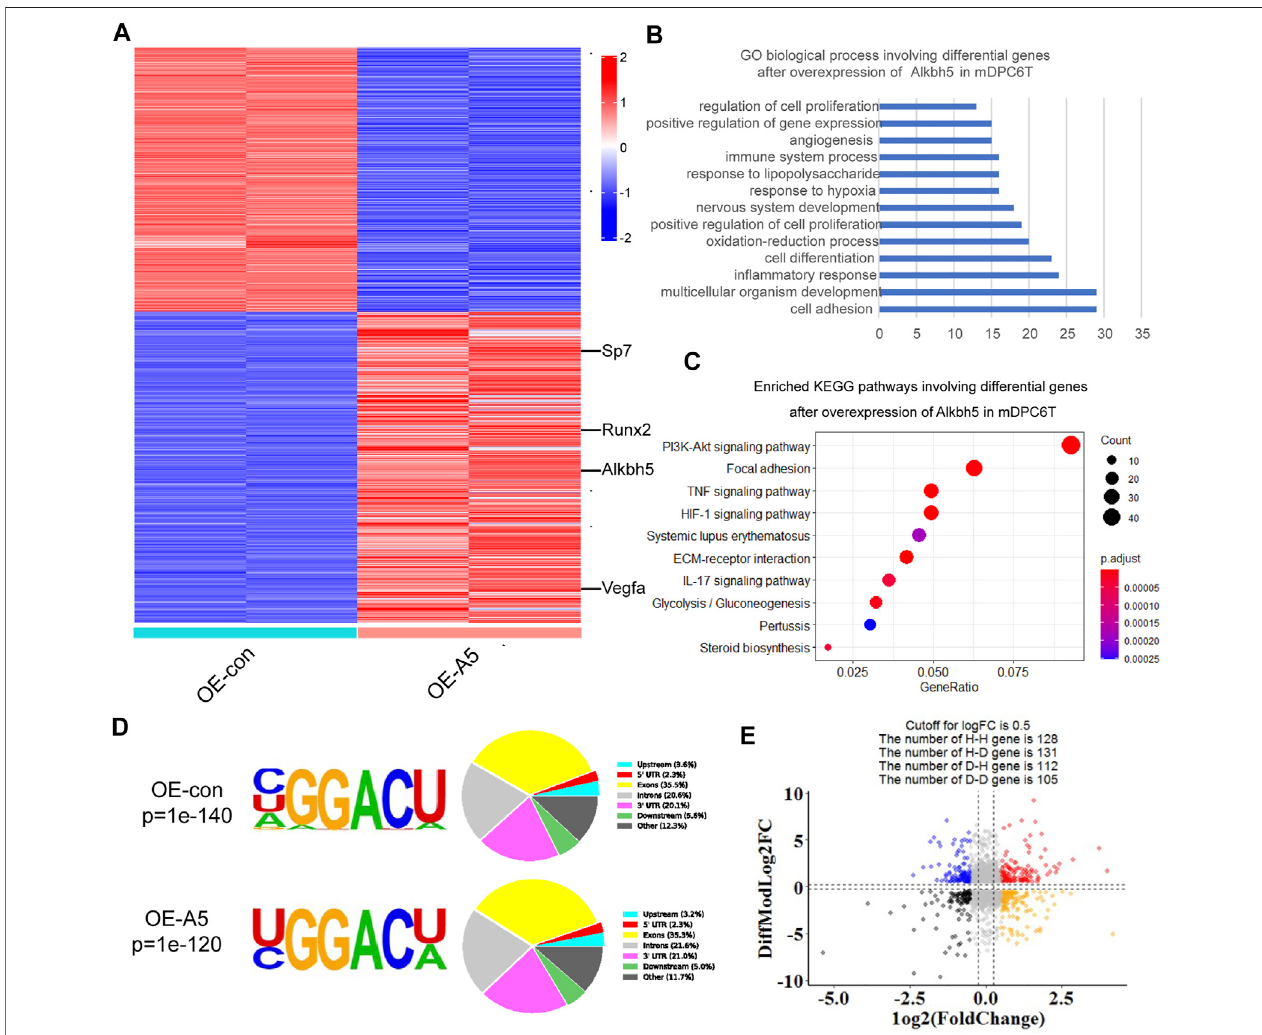
FIGURE4| Whole-transcriptomem 6 A-seqandRNA-seqanalysisof Alkbh5 downstreamregulatorygenes. (A) Heatmapshowsthedifferentiallyexpressedgenes related to Alkbh5 in mDPC6T cells. (B,C) GO and KEGG enrichment analyses of differentially expressed genes in Alkbh5 -overexpressing mDPC6T cells. (D) Speci fi c motif sequences of the Alkbh5 overexpression and control groups. Portions of the m 6 A peak are distributed in upstream, 5 ′ -UTR, Exon, Introns, Downstream, and 3 ′ - UTR across or in other regions of the entire set of mRNA transcripts. (E) Distribution of genes with a marked change in both m 6 A level and total transcript level in Alkbh5 overexpressioncellscomparedtothatincontrolcells.Alkbh5,AlkBhomologH5;GO,GeneOntology;KEGG,KyotoEncyclopediaofGenesandGenomes;m 6 A, N6-methyladenosine; 5 ′ -UTR, 5 ′ untranslated region; m 6 A-seq, m 6 A sequencing; RNA-seq, RNA sequencing.